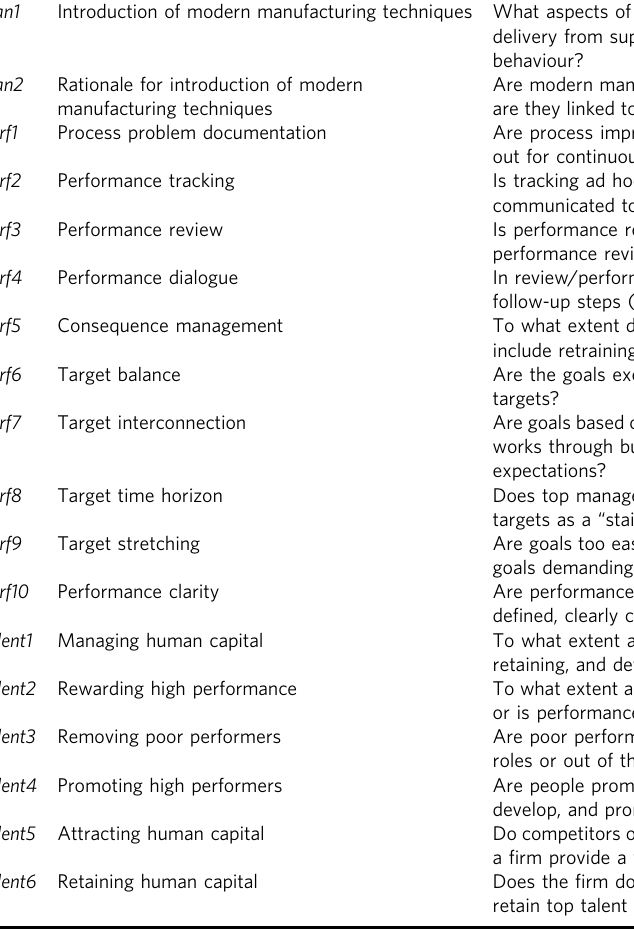
Table 1 Management practice dimensions.